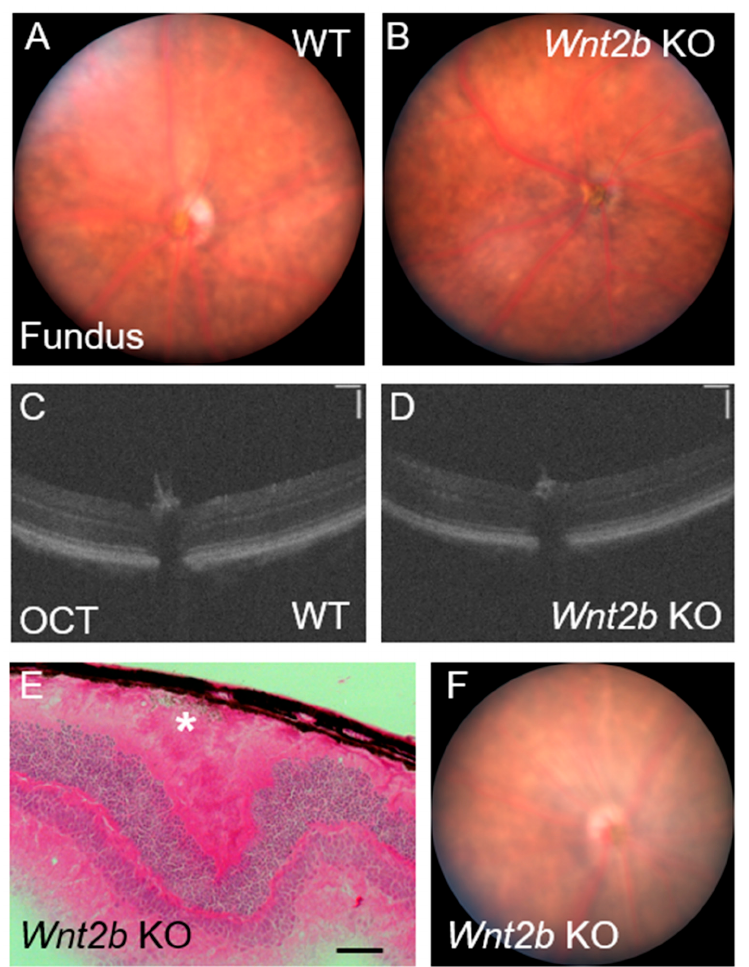
Figure 5. In vivo fundus and OCT imaging does not reveal abnormalities in Wnt2b KO mice. ( A , B ) Fundus images from 4-month-old WT ( A ) and Wnt2b KO ( B ) mice. No obvious retinal spotting or abnormalities can be observed. n= 4 mice/group (n = 2 at P30, n = 2 at 4 months). ( C , D ) OCT images from 2-month-old WT ( C ) and Wnt2b ( D ) KO mice. No obvious disruptions to retinal structure or lamination can be detected. n = 2/group. Scale bars: 100 µm. ( E , F ) H&E staining ( E ) of P30 Wnt2b KO mice, showing the rosette-like formation and ectopic cells (*), and fundus image ( F ) for